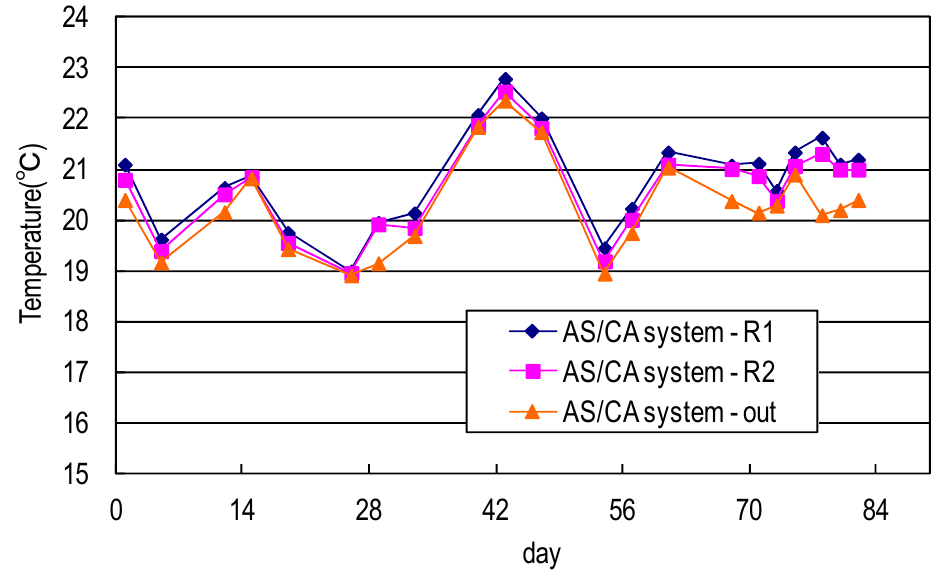
Figure 6. Temperature of synthetic domestic sewage treated using AS / CA system.